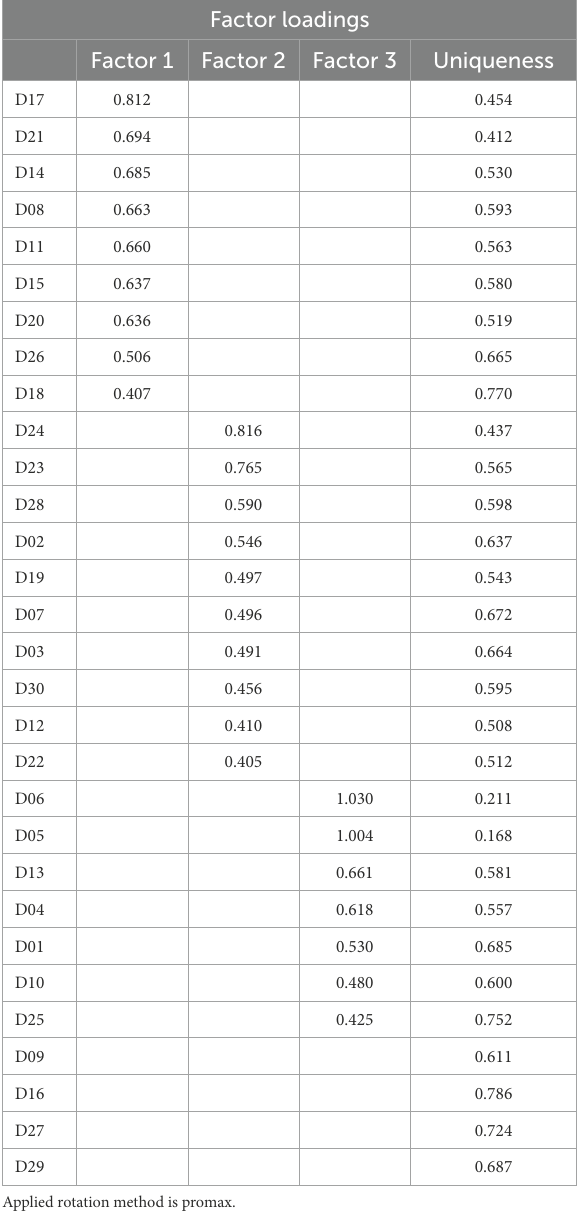
TABLE 2 Loadings pattern matrix EFA. TABLE 1 Descriptive statistics of the Italian Fear of Pain Questionnaire